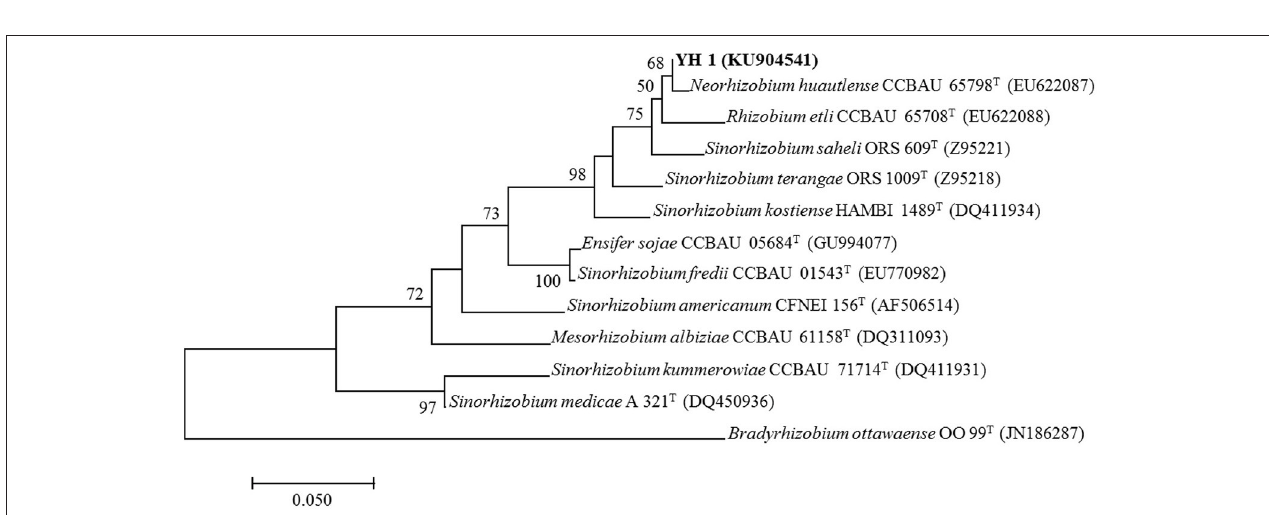
FIGURE 3 | Concatenated tree of L. leucocephala -isolated strain YH1 combining atpD-glnII-recA-rpoB (1,631 bp), generated using maximum likelihood method (Kimura 2-parameter model) with 1,000 repetitions of bootstrap value. Accession numbers retrieved from GenBank are shown in parentheses. The scale bar denotes 2% nucleotide substitutions per site. Values lower than 50 are not shown at the nodes.